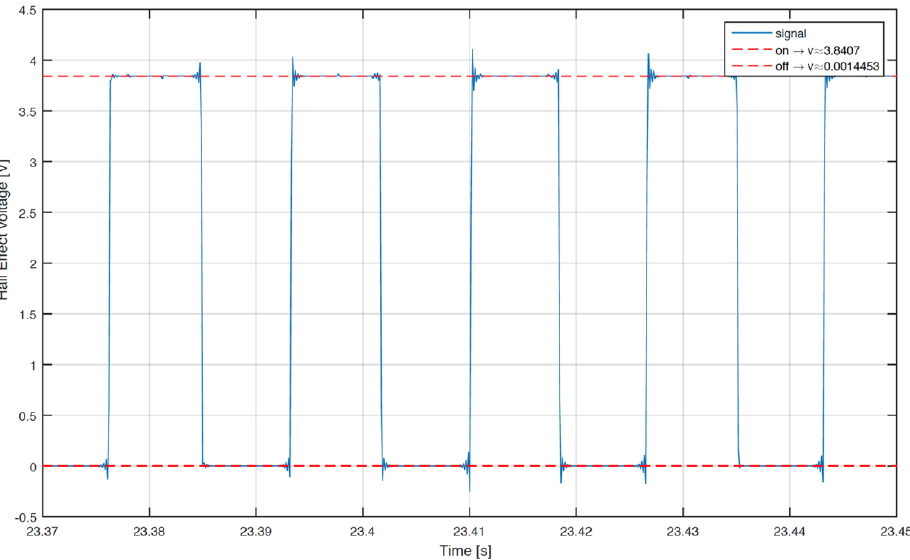
Figure 12. Sample of raw data from the Hall effect sensor.